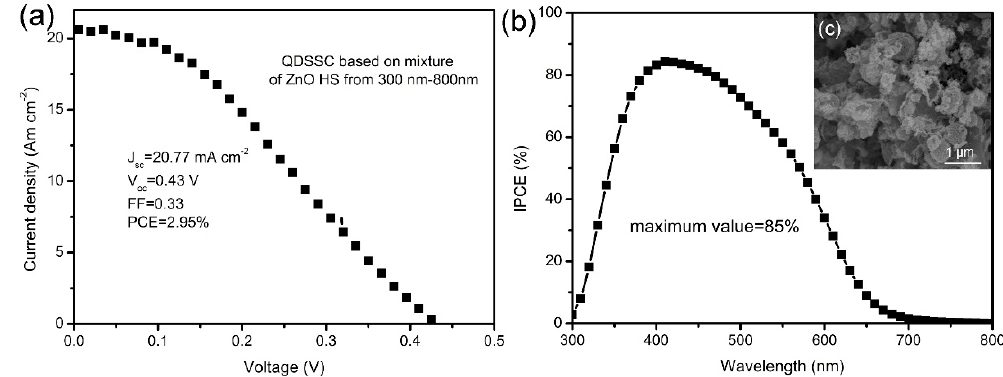
Figure 10. ( a ) The J–V curve of QDSSC based on a mixture of ZnO HS in different sizes, from 300–800 nm; ( b ) the corresponding IPCE spectrum; ( c ) the SEM image of the corresponding photoanode.